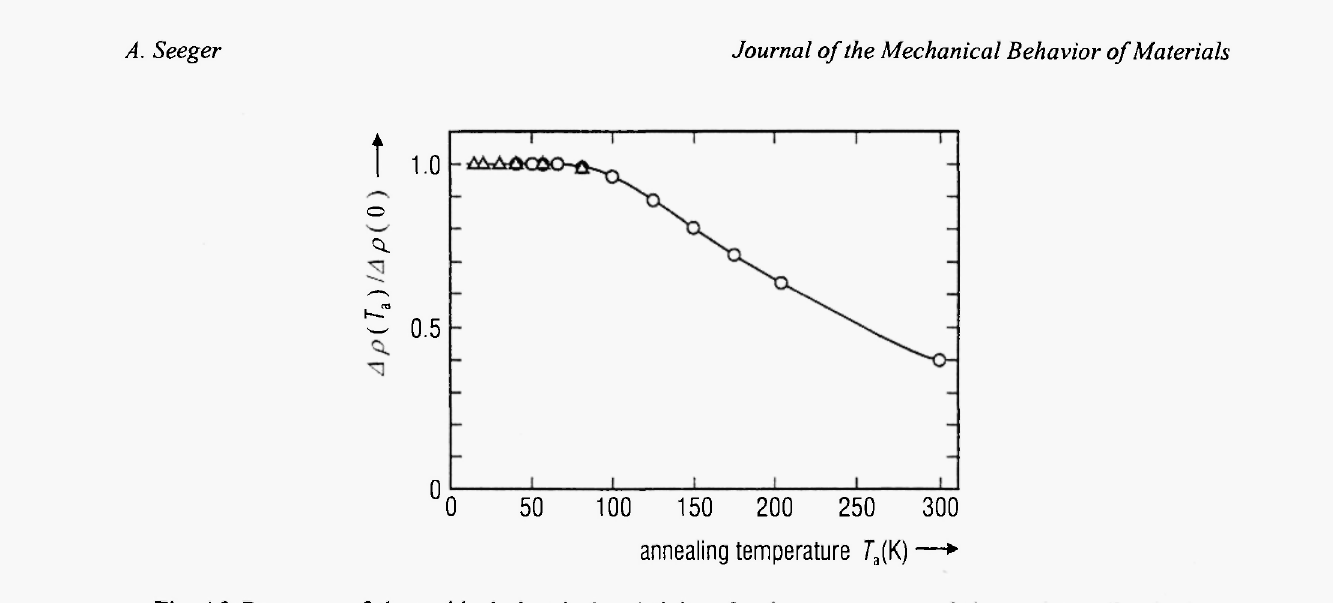
Fig. A2: Recovery of the residual electrical resistivity after low-temperature fatigue of two Cu single crystals (isochronal anneals for 1.8 · 103 s at T to cyclic deformation at 18 Κ for 5.5 · 10 cycles (Δ) and at 14 Κ for 5.25 · 10 cycles